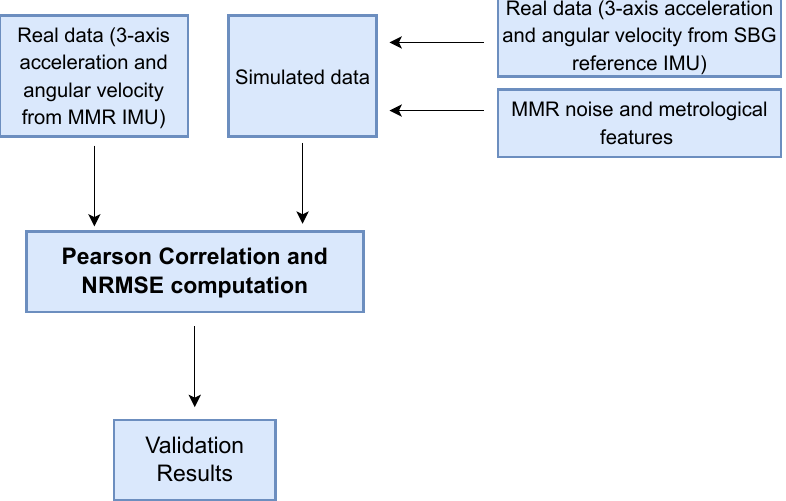
Figure 4. Block diagram to perform the validation procedure.